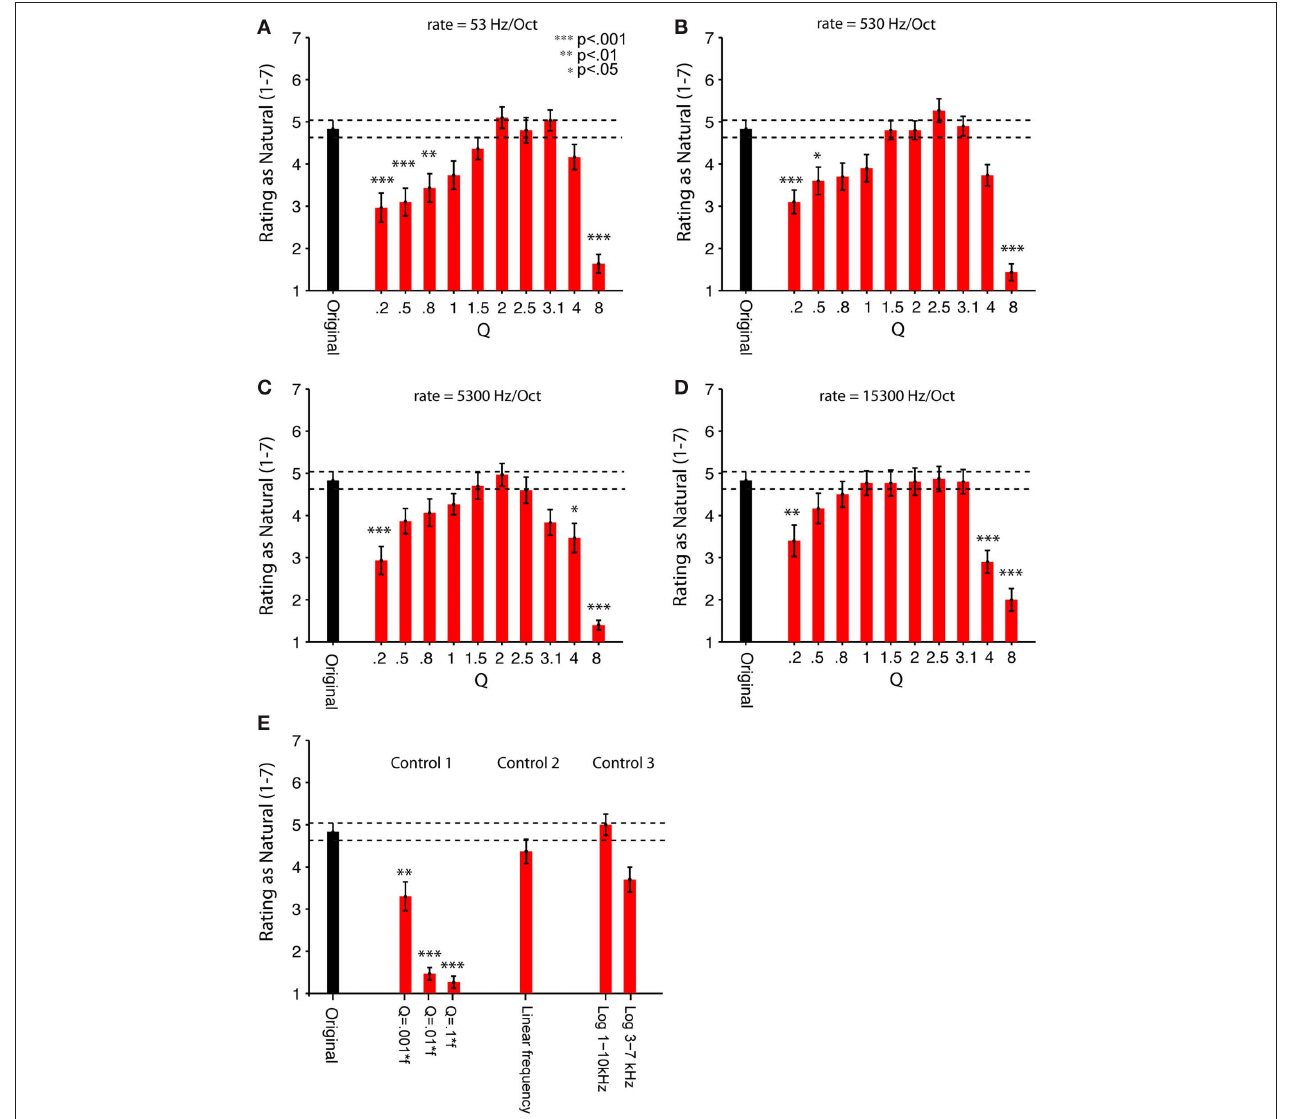
synthetic sounds, where the frequency of the chirps was drawn from a uniform linear distribution (“Linear Frequency”). Control experiment 3: Rating of 2 control synthetic sounds, where the frequency of the chirps was restricted to a subband of frequencies, either 1–10 kHz (“Log 1–10 kHz”) or 3–7 kHz (“Log 3–7 kHz”). Error bars = SEM. To evaluate the contributions of chirp rate and Q to the perception of naturalness, a two-way, repeated measures ANOVA was performed on data in (A–D) , revealing the significant main effect of Q [ F (9, 21) = 4.958, p < 0.0001]. There was no significant effect of rate, or “ Table S2 in Supplementary Material” for a table of significant